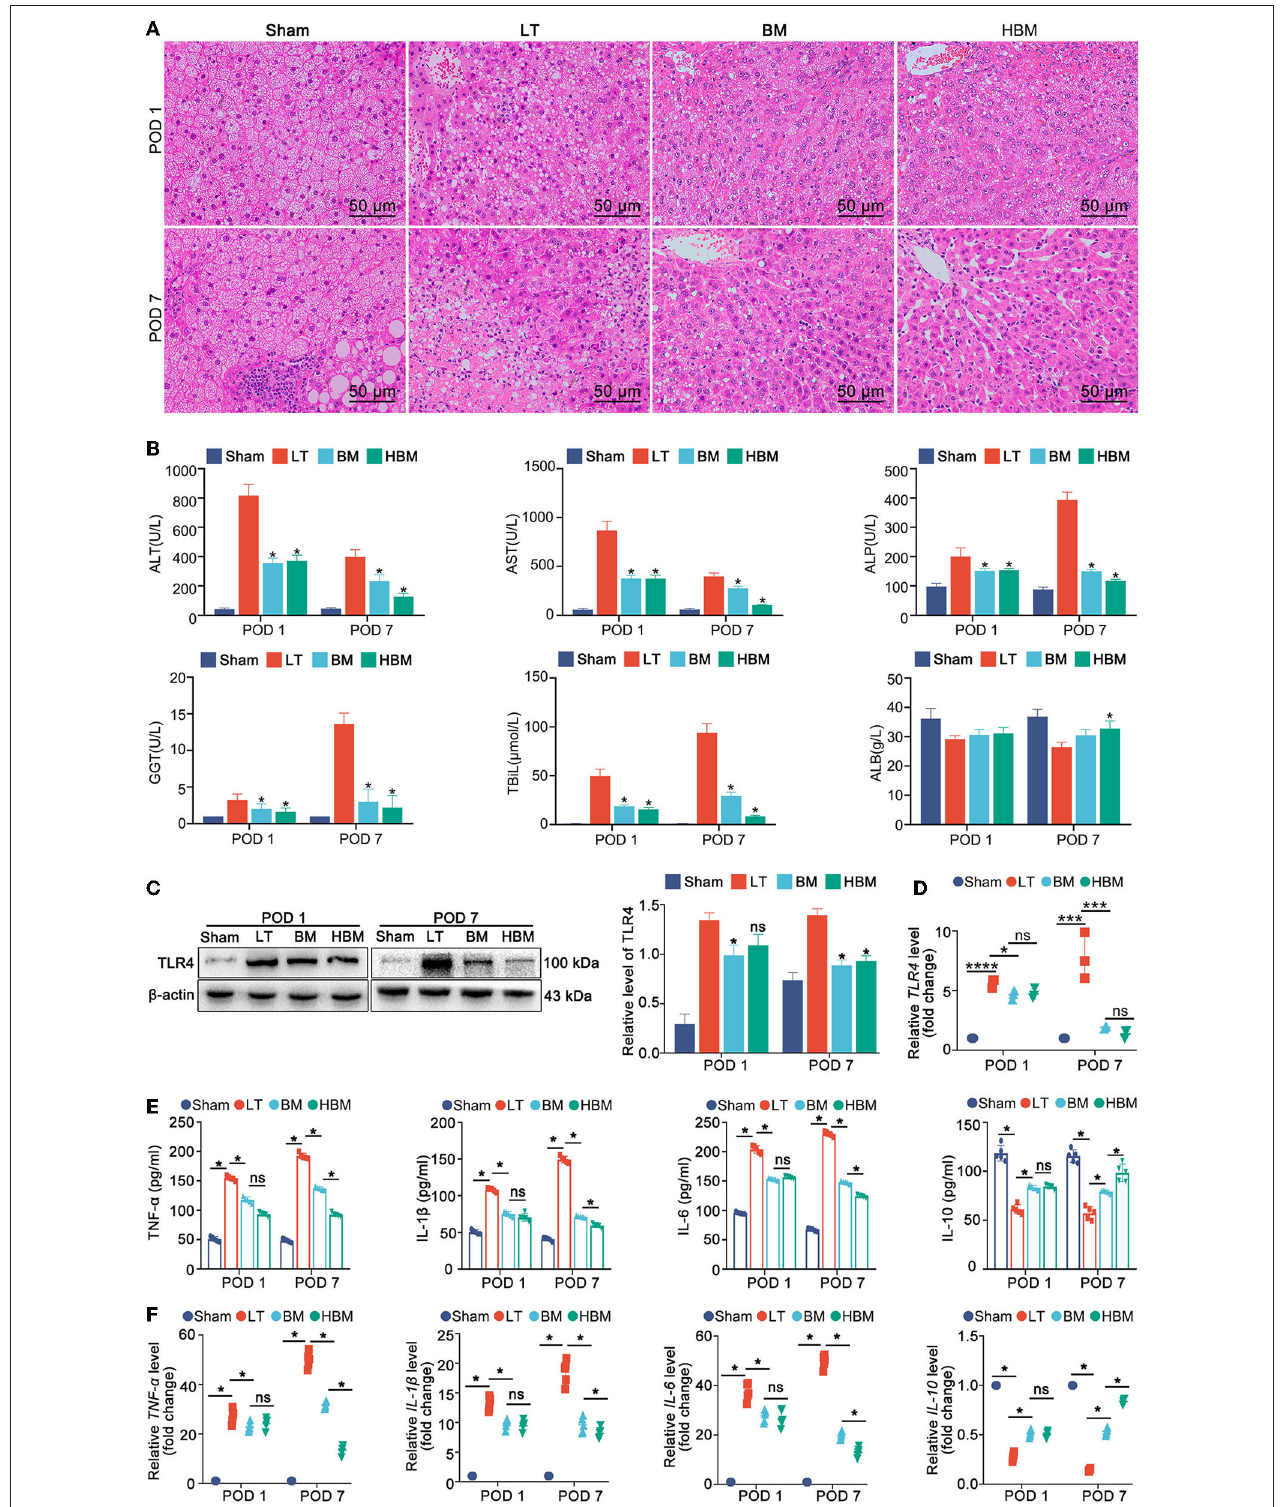
FIGURE 2 | Changes in the steatotic liver graft histology, liver biochemical examination, and plasma inflammatory indexes in each group. (A) Histopathology of transplanted livers at different time points (H&E staining, × 200). (B) Transplanted liver function. On POD 1, the ALT level in the LT group (817.20 ± 77.63 U/L) was significantly higher than that in the BM group (355.70 ± 34.04 U/L) and the HBM group (370.60 ± 38.63 U/L) ( P < 0.05), while the difference between the BM group